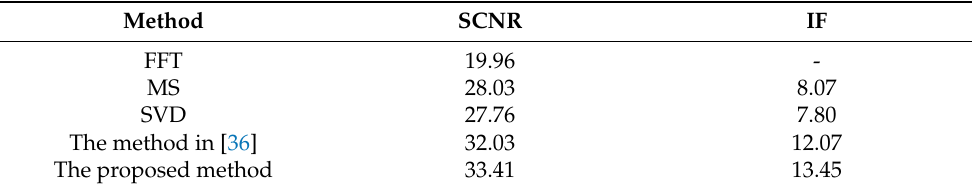
Table 1. Quantitative results of